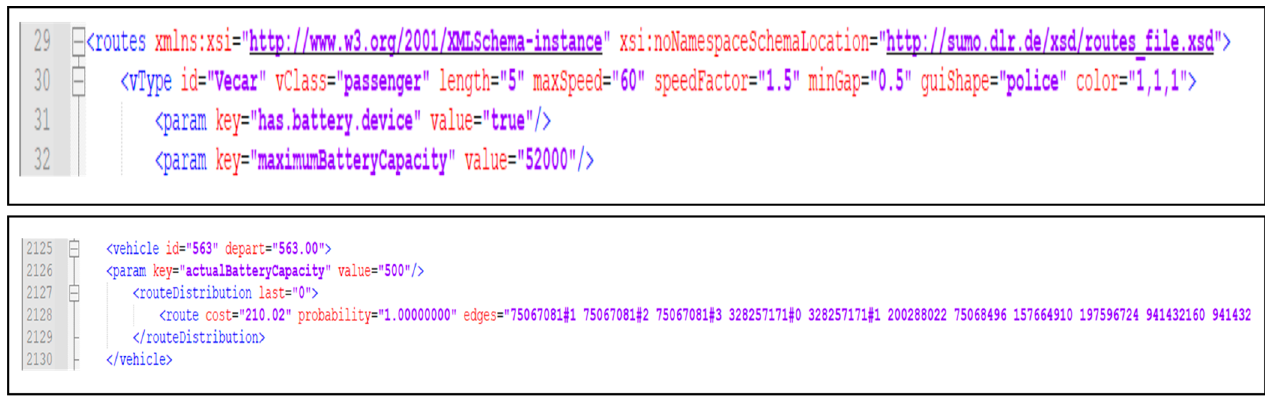
Figure 5. Lines of code. Figure 5. Lines of